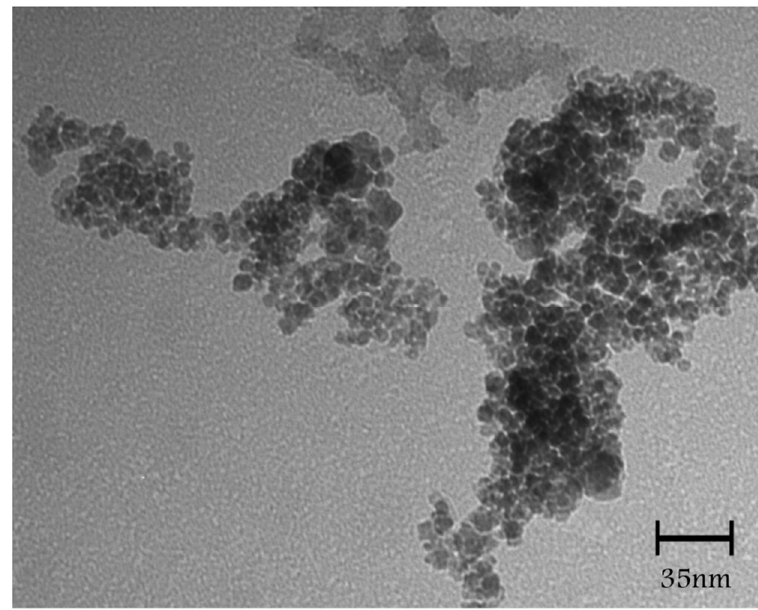
Figure 2. TEM image of the Lys@Fe 3 O 4 nanoparticles.